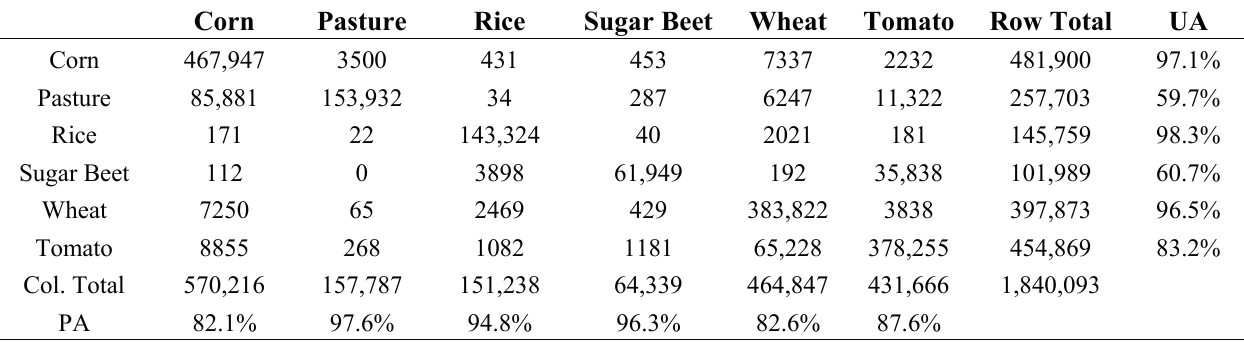
Table 1. Confusion matrix of SVM-ECS classification for Ikonos test image. Corn Pasture Rice Sugar Beet